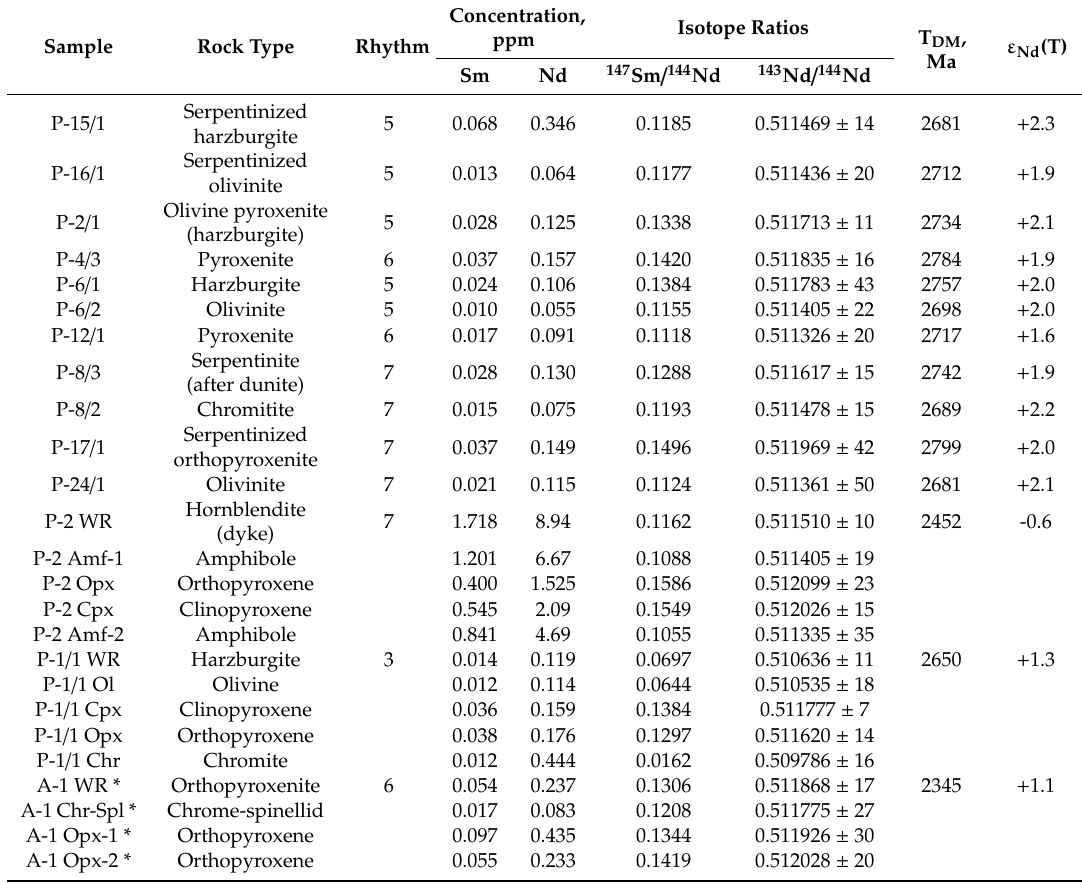
Figure 6. Sm–Nd isochrones for rocks and minerals of rhythmically layered series in the complex. Table 1. Results of isotope Sm–Nd studies of rocks and minerals of the Pados-Tundra complex.